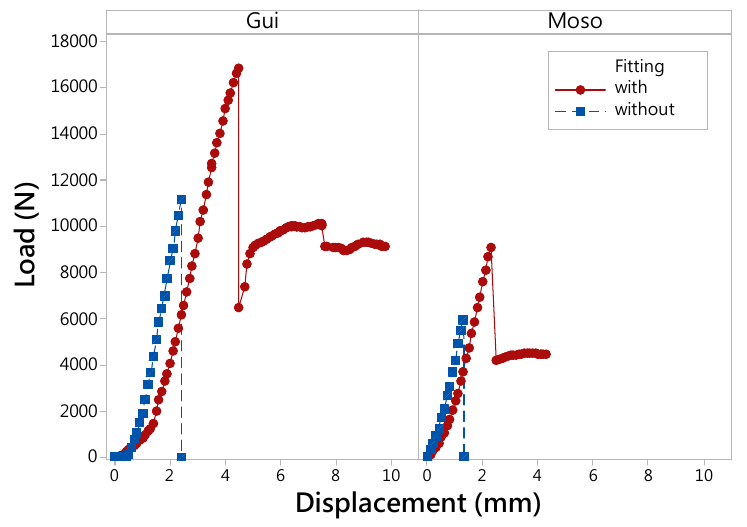
Figure 10. Failure modes for various joints.